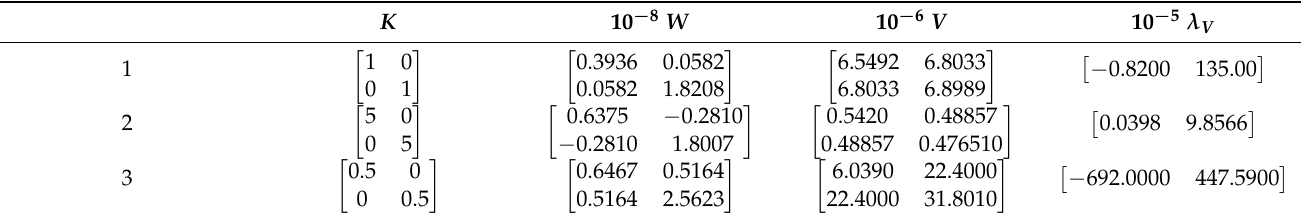
Table 4. Results of three kinds of feedback design for the system.